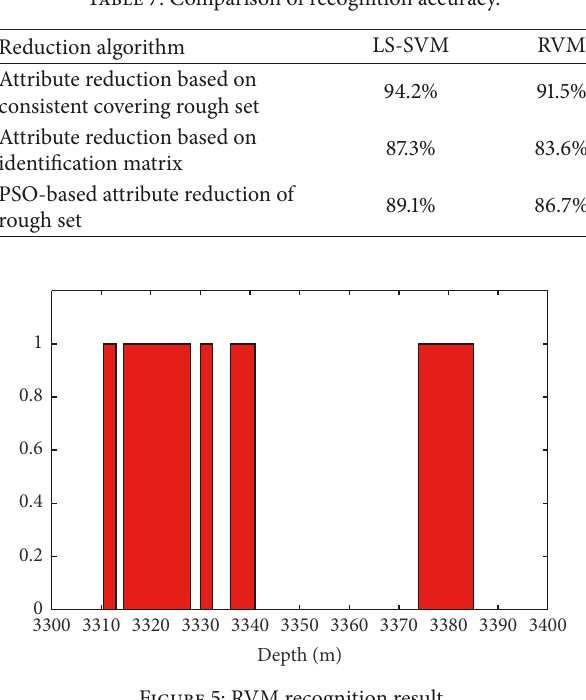
Figure 5: RVM recognition result.